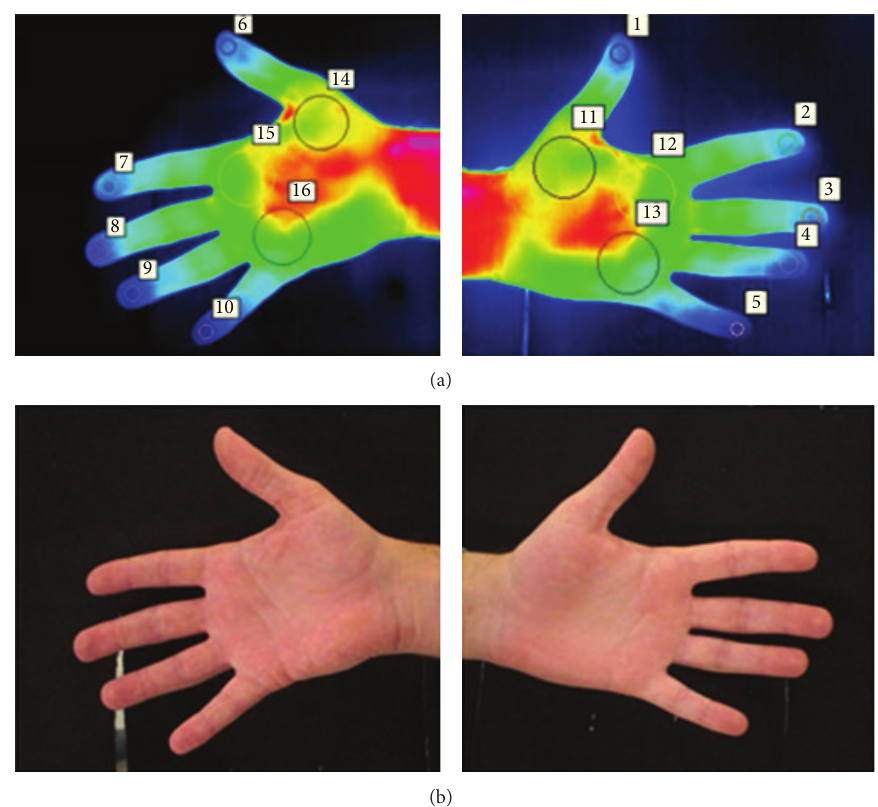
Figure 4: Participants were asked to spread the palms and fingers of each hand in front of the cameras one at a time, while a thermal image (a) and a visual image (b) were acquired. Measurement regions were then annotated on the thermal images (a) for further